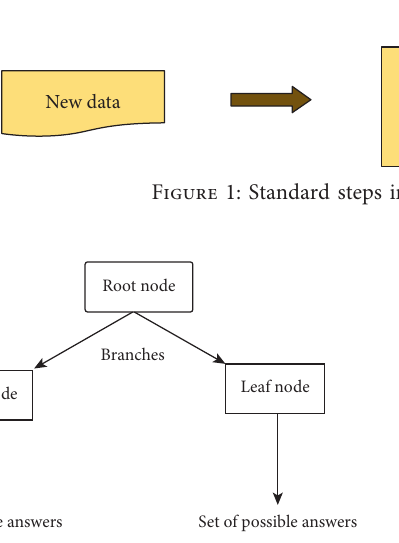
Figure 2: Representation of Decision Tree.